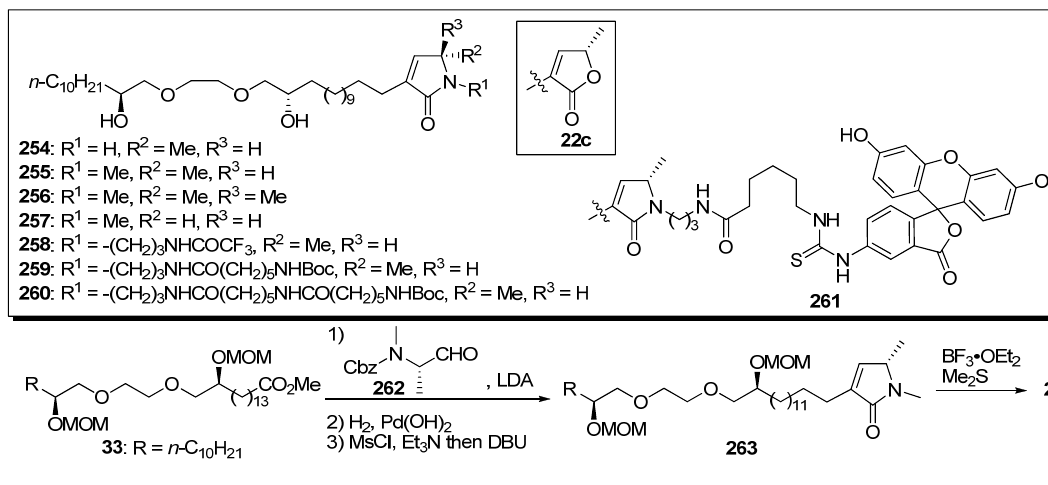
Table 19. Cytotoxicity screening of lactam-containing